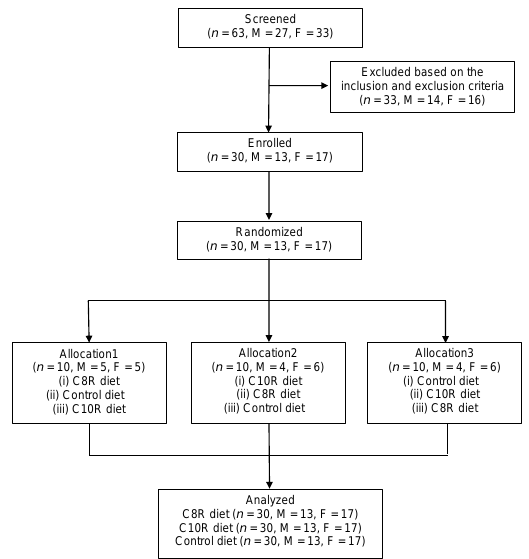
Figure 2. Flowchart illustrating the selection and participation of study participants in the present study. Thirty-six female and 27 male participants underwent screening, which included a medical history, physical, and blood tests. Of the 63 participants, 19 female and 14 male participants were not assigned. The remaining 17 female and 13 male participants were randomly allocated to 3 groups to receive the intervention (control diet: 0 g of MCTs; C8R diet: 6 g of octanoic-acid rich MCTs; C10R diet: 6 g of decanoic-acid rich MCTs). No participants dropped out and were excluded. The data from 17 female and 13 male participants were analyzed. F: females; M: males; C8R: octanoate-rich MCTs; C10R: decanoate-rich